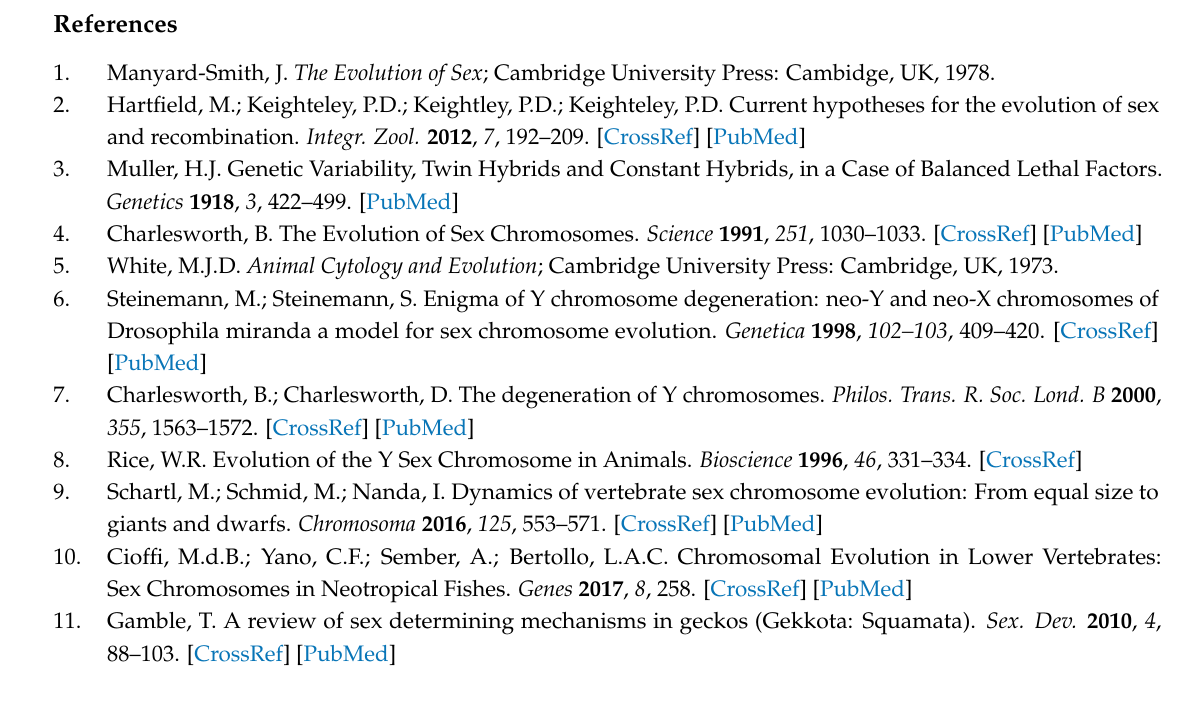
Figure S1: Scheme of chromosome painting in Nocarodeini species with NcyXl and NcyY DNA probes, Figure S2: Scheme of chromosome painting in Nocarodeini species with NruXl and NruY DNA probes, Figure S3: Scheme of chromosome painting in Nocarodeini species with NtaXl and NtaY DNA probes, Figure S4: Scheme of chromosome painting in Nocarodeini species with PtoXl and PtoY DNA probes, Figure S5: Definition of intensity levels of hybridization signals on the example of N. cyanipes chromosome painting with NcyXl and NcyY DNA probes, Figure S6: Definition of intensity levels of hybridization signals on the example of N. cyanipes chromosome painting with NcyXl and NcyY DNA probes after VISSIS